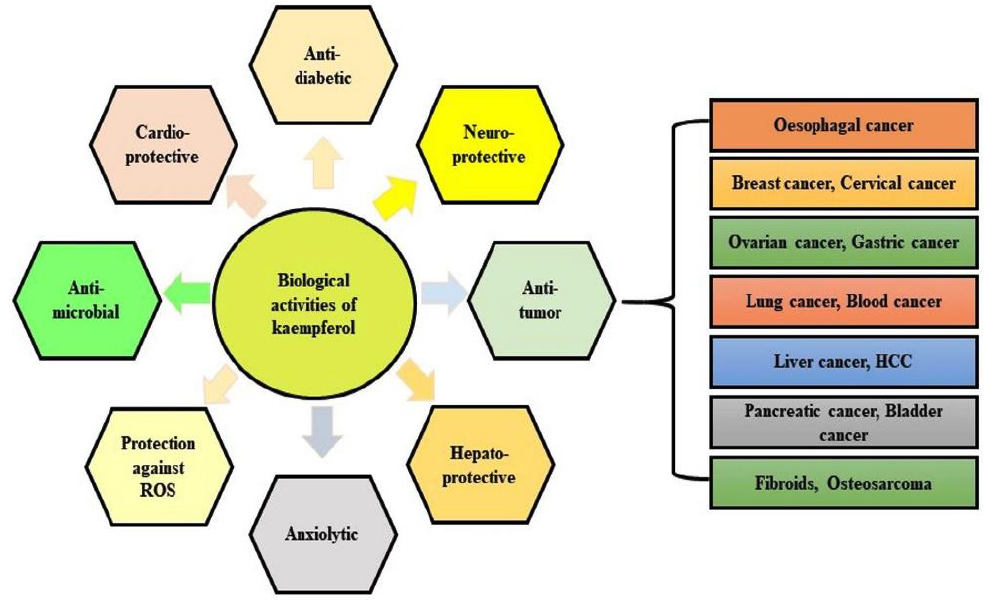
Figure 1. Pharmacological activities of kaempferol.